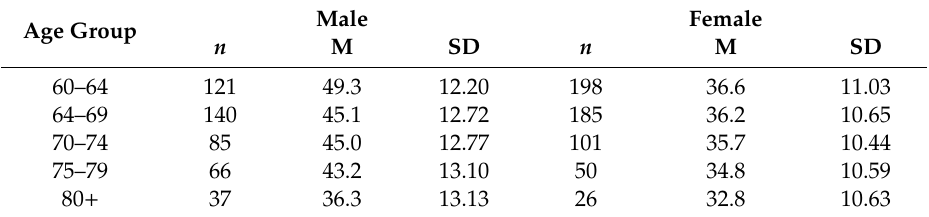
Table 8. Relative grip strength based on age group and gender, Unit: %.